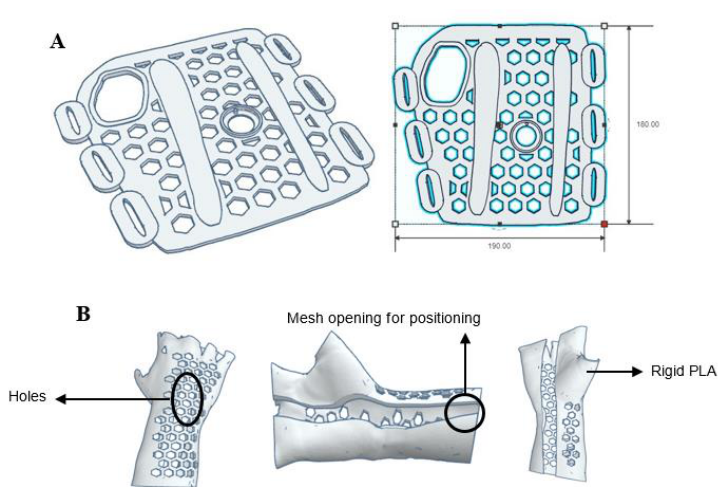
Figure A3. Immobilization mesh made of PLA ( A ) after printing and ( B ) deformed in the shape of the patient ’ s wrist after heating in water.